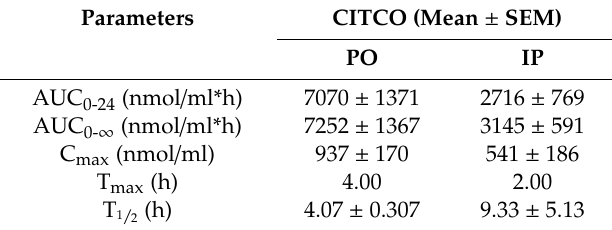
Table 2. CITCO Pharmacokinetic parameters from hCAR-TG-mice dosed 20mg / kg via PO and IP